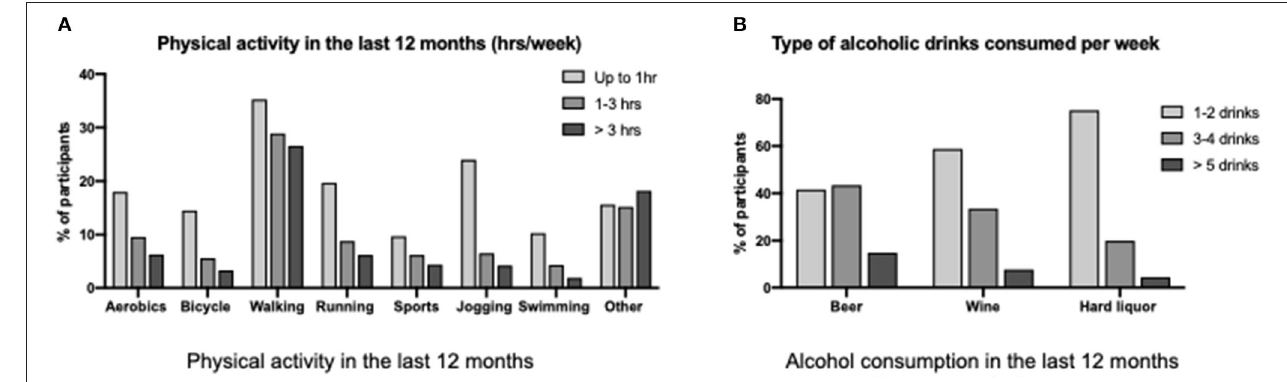
FIGURE 3 | Lifestyle factors reported by participants. (A) Physical activity. (B) Alcohol consumption.